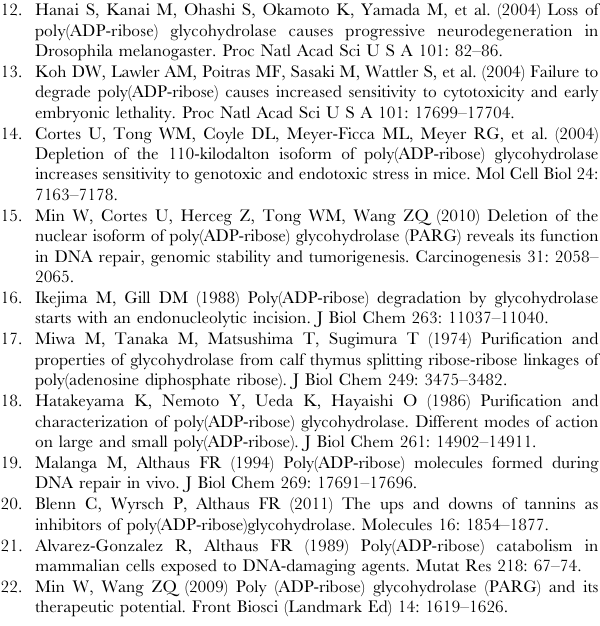
mutants. The red asterisk indicates the expected position for mPARG(439–959). Figure S4 A potential secondary iso -ADPr binding site. (A) Stereoview of the iso -ADPr binding site. R478, D480, F491 and T493 are highlighted in pink sticks. These residues are highly conserved in vertebrate PARGs. Fo - Fc difference density (grey mesh) is calculated when iso -ADPr is omitted (contoured at 2.5 s ). (B, C) iso -ADPr is also observed in both E748Q and E749Q mutants structures at the same site. E748Q is in p2 1 2 1 2 space group (B) , and E749Q is in p2 1 space group (C) . Fo - Fc difference density (grey mesh) is calculated when iso -ADPr is omitted (contoured at 2.5 s ). (PDF) Figure S5 The 2 9 -OH group of the adenine-linked ribose is exposed to solvent. The surface of the mPARG is shown as grey. ADPr analog ADP-HPD is highlighted as sticks. Unlike bacterial PARG, mPARG does not block the 2 9 -OH of the adenine-linked ribose. This allows the binding of (n + 1) ADPr unit. This structure feature supports that mPARG has both exo- and endo-glycohydrolase activity. Table S1 Statistics for data collection and structure refinement of mouse PARG(439–959)